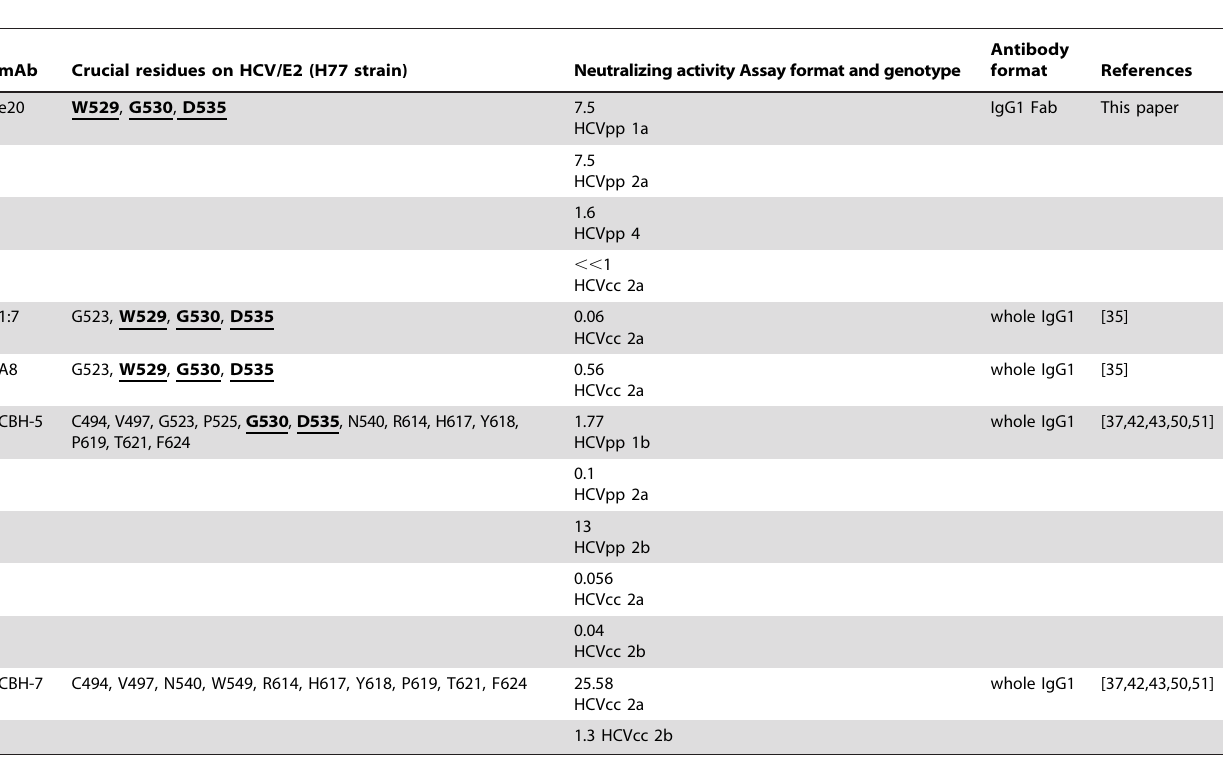
The E2 residues involved in the binding of each antibody are reported (those crucial for e20 binding are in bold and underlined). Only the concentrations giving 50% neutralization (IC50) against HCV pseudoparticles (HCVpp) derived from different genotypes, or against HCV cell culture (HCVcc) strains, are reported. Punctual IC50 values are not available for mAbs 1:7 and A8 against HCVpp [35], and for CBH-5 and CBH-7 against HCVpp derived from genotypes 1a, 3a, 4, 5 and 6 [37,42,43,50,51]. E20 is the only monoclonal tested as Fab